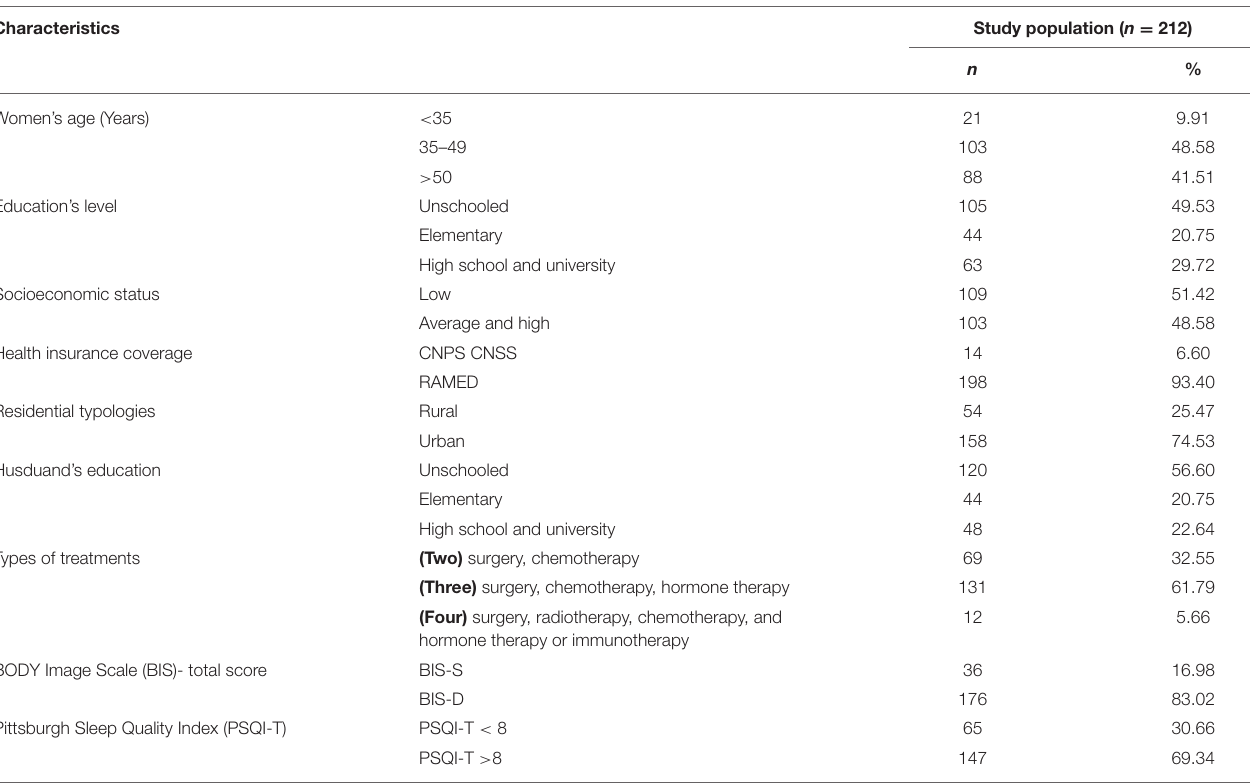
TABLE 1 | Demographic and clinicopathological characteristics of the breast cancer sample.